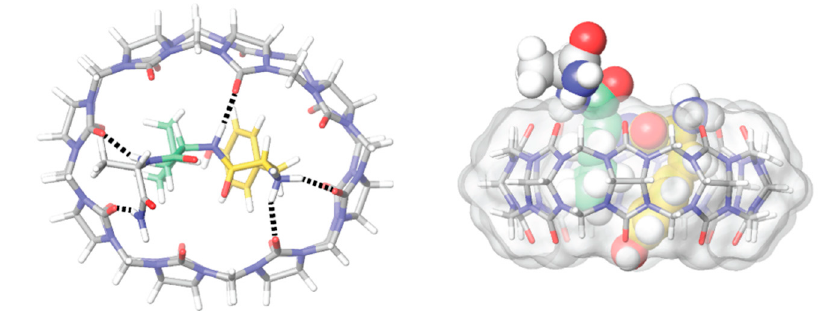
Figure 21. Semiempirical structure obtained by Smith et al. (2015) of the complex CB8-(Tyr-Leu-Ala)—up view (left) with the electrostatic interactions represented by dashed lines, and side view (right), where it is observable the two N -terminal residues inserted in the cavity of the macrocycle. Reprinted with permission from [125]. Copyright (2015) American Chemical Society.